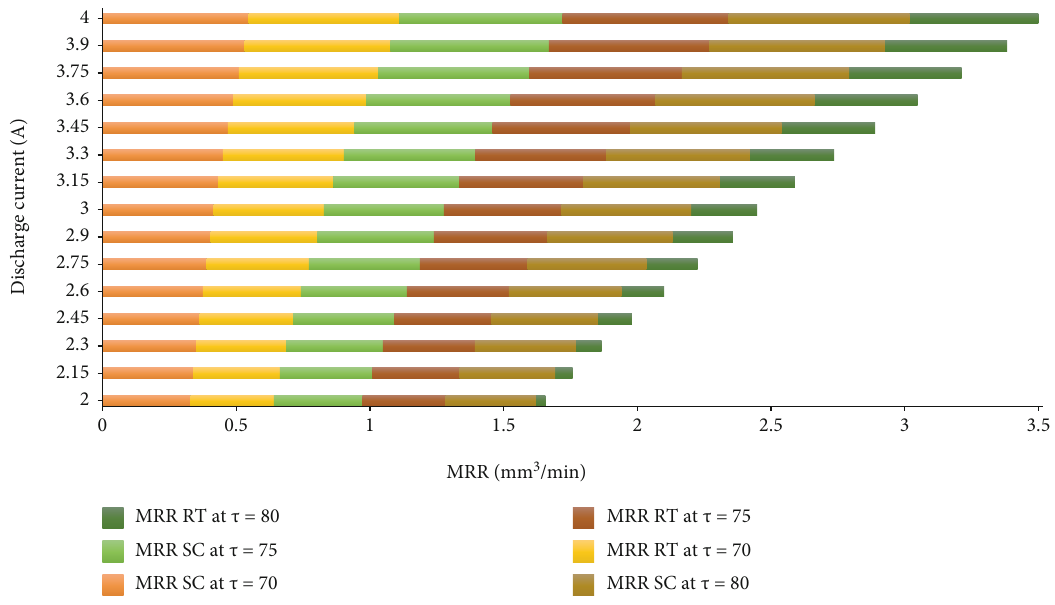
Figure 5: MRR vs. discharge current for two types of electrodes at T